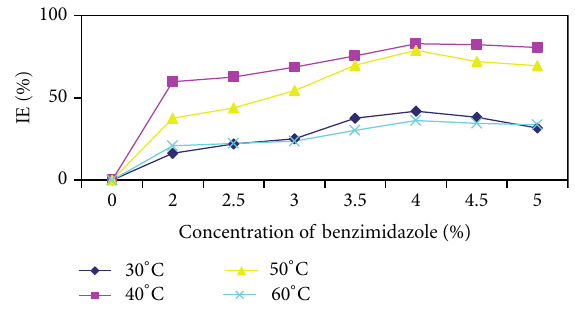
F 2: Inhibition efficiency of Benimidazole at various tempera- tures.